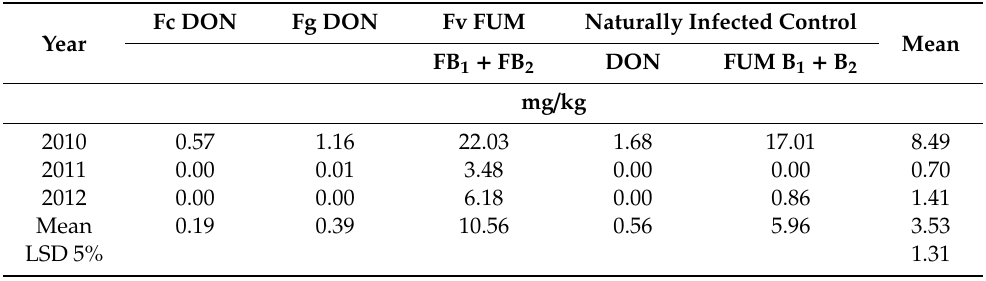
Table 19. Toxin contamination across hybrids following silk channel inoculation of ten maize hybrids against Fusarium spp., 2010–2012,